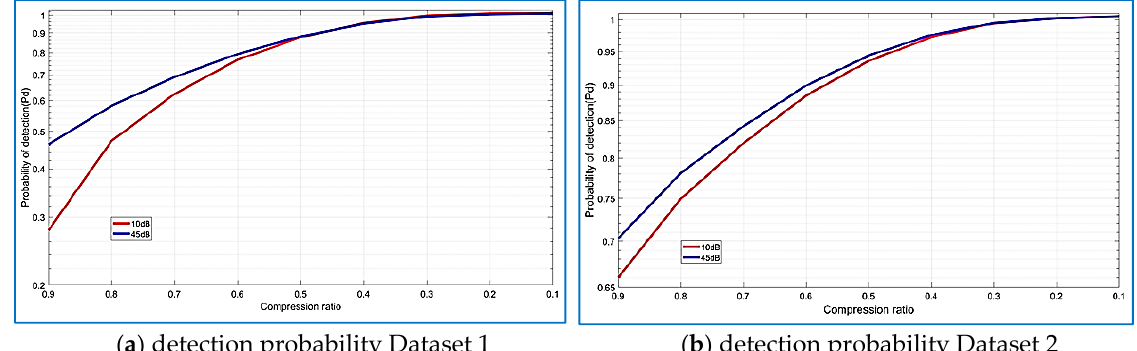
Figure 26. Distribution of the detection probability and compression ratio for several SNRs, Dataset 2.